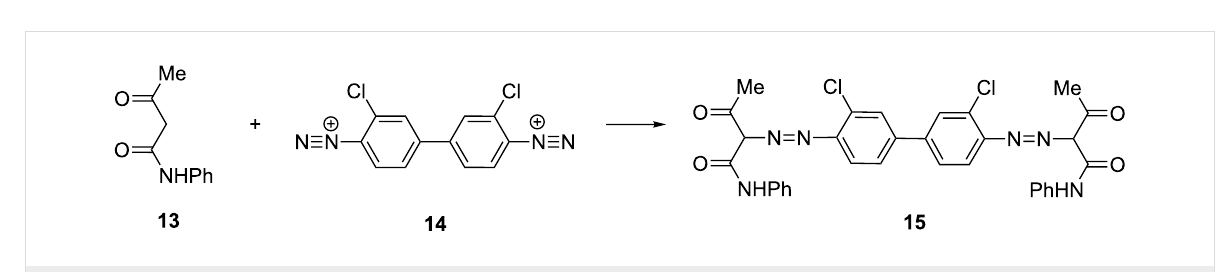
Scheme 5: Synthesis of yellow pigment 12 in a micro-mixer